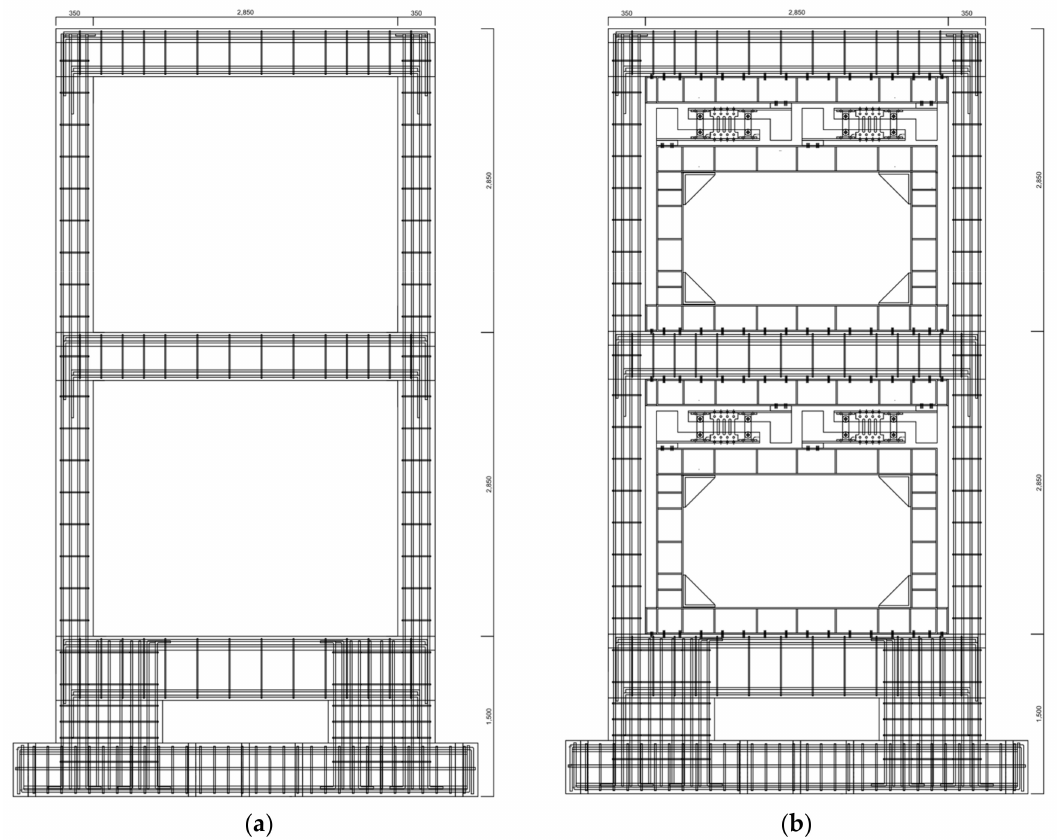
Figure 11. Bar arrangement details of the specimens: ( a ) existing frame with no reinforcement applied (PD-FR) and ( b ) frame retrofitted with NBSD-WSCS